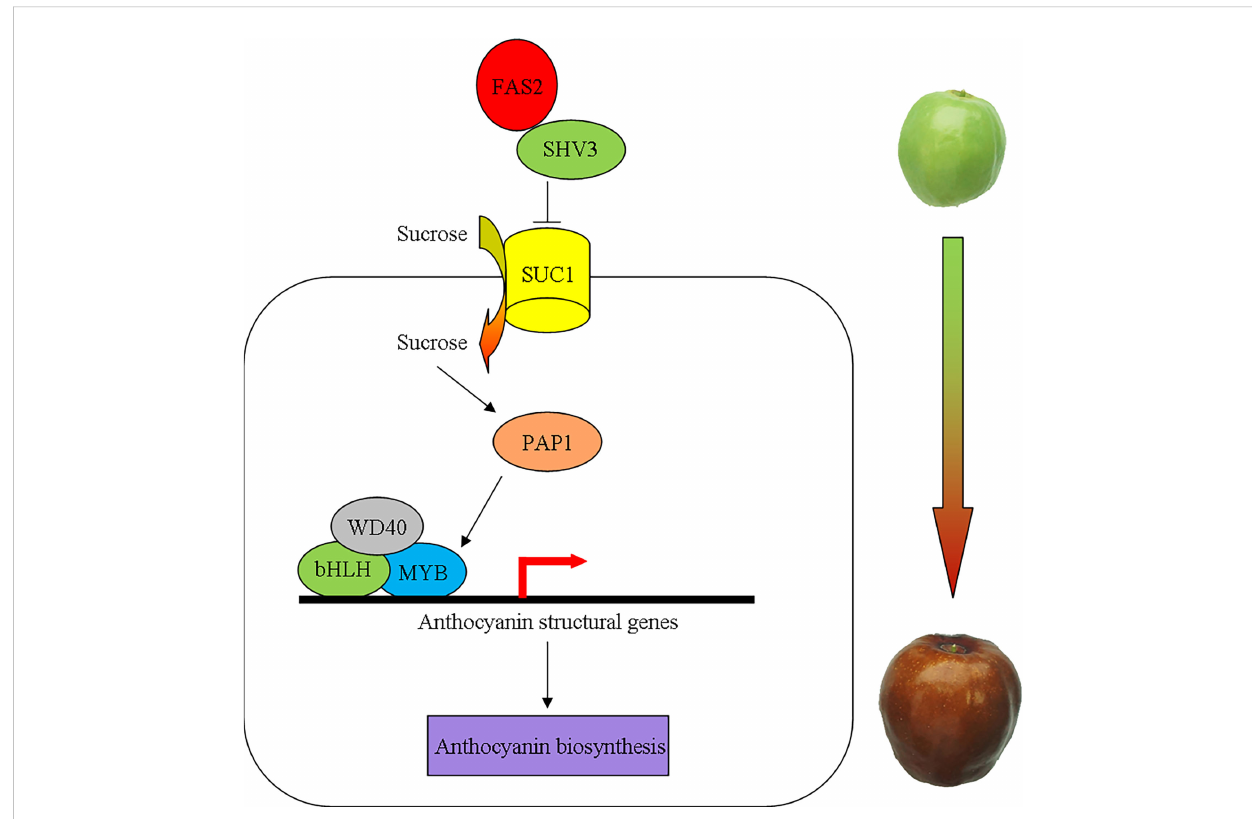
FIGURE 9 A schematic model for the possible molecular mechanism of anthocyanin accumulation regulated by FAS2 . FAS2 enhances the sucrose accumulation via the plasma membrane sucrose-proton symporter SUC1 by inhibiting SHV3 protein activity. The higher sucrose concentration causes an increase in the expression of MYB75 genes. MYB75 interacts with bHLH and WD40 to form the MBW complex positively regulating the expression of anthocyanin structural